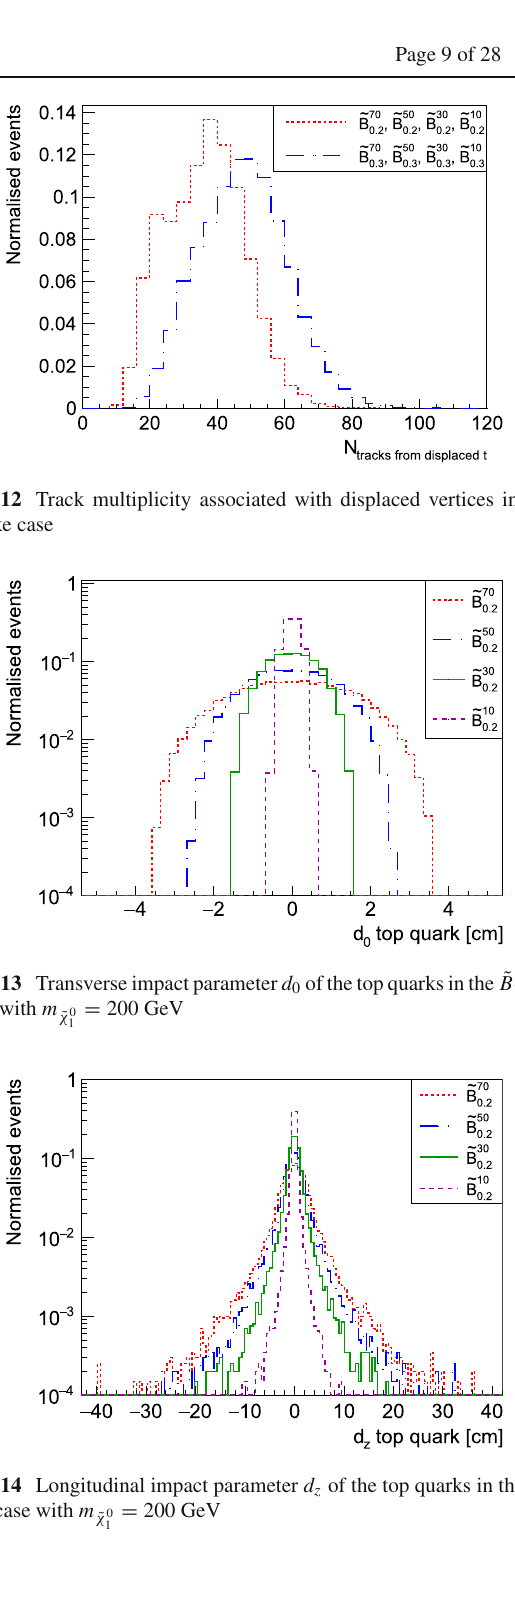
= 200 GeV is plicity (see Fig. 25). The multiplicity for m ˜ χ 0 1 equivalent to the prompt t ¯ t signal with a mean value of 4 . 3, = 400 GeV the number of jets is higher whereas for m ˜ χ 0 1 with a mean value of 7 . 3. The first value remains low com- pared to the expected one (between 6 and 10 quarks in